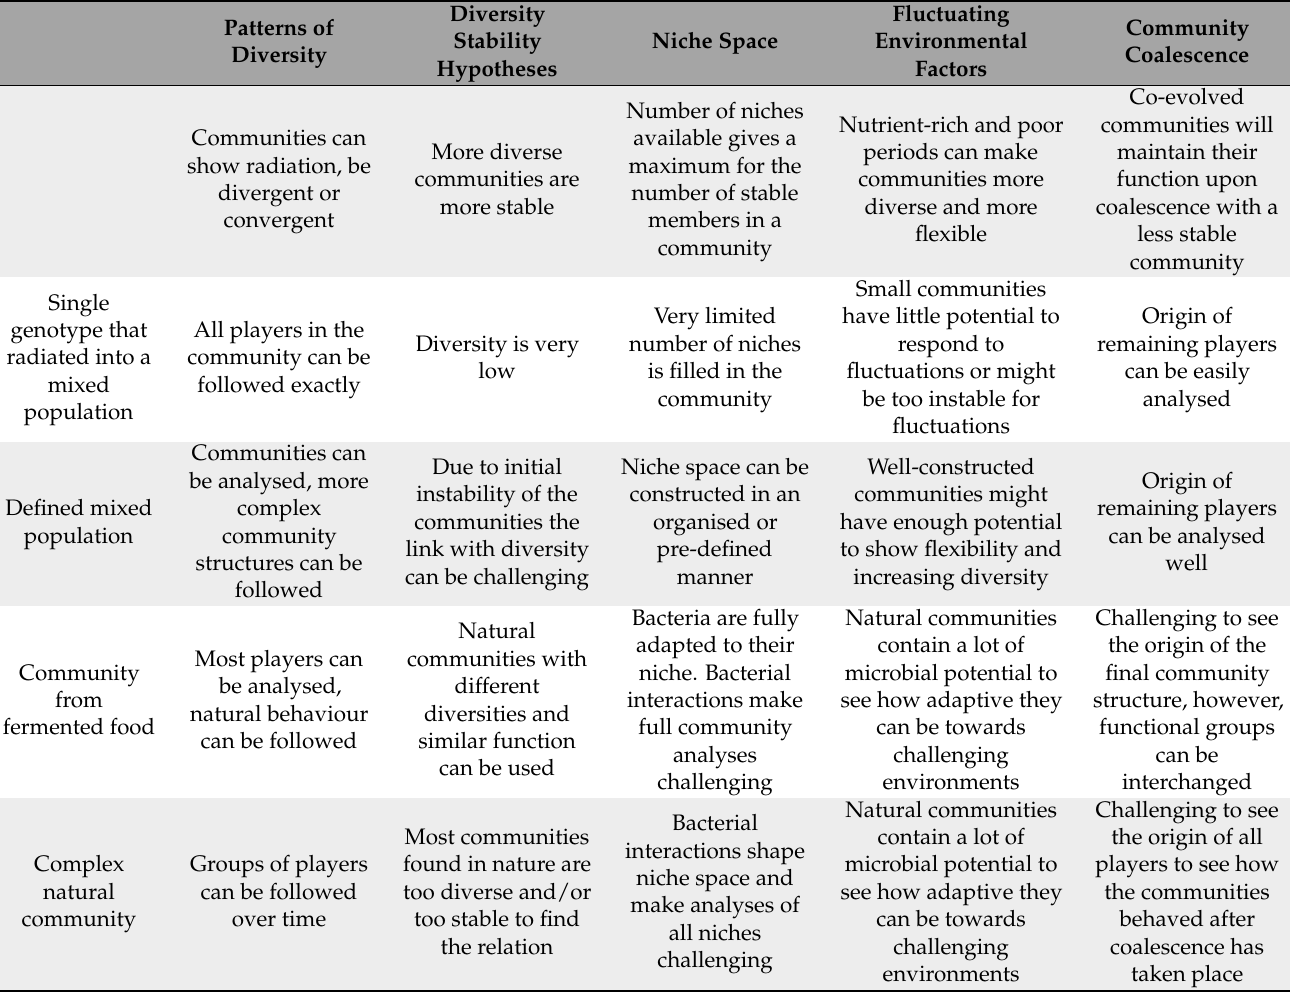
Table 1. Advantages and disadvantages of various model systems. This table lists the advantages and disadvantages of using various model systems mentioned in the paper to analyse different evolutionary hypotheses. The different hypotheses are listed in the top row, followed with a short description in the second